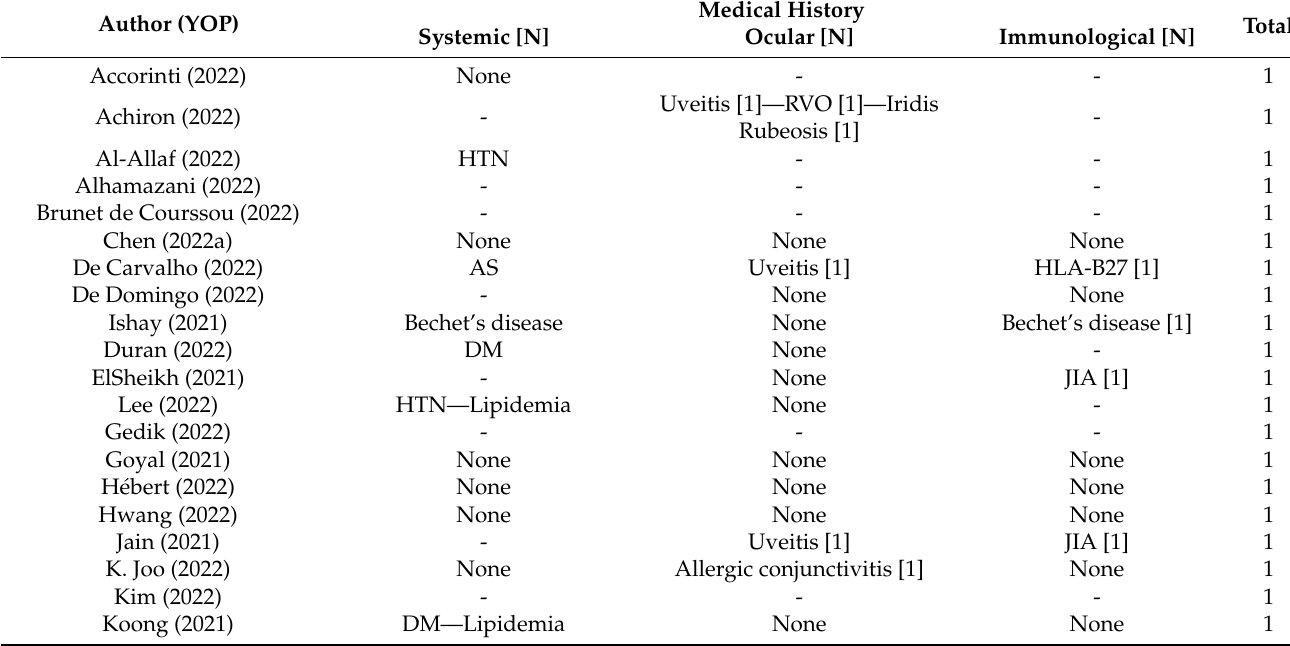
Table 3. The systemic, ocular, and immunologic history of vaccine-associated uveitis